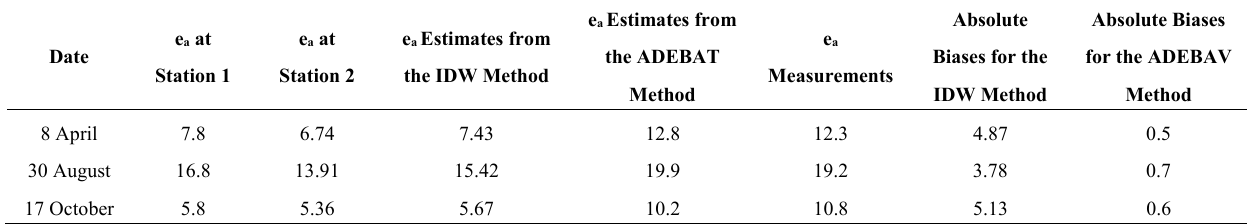
Table 3. Comparisons between the estimated vapor pressure by the IDW method and the ADEBAT method and the e a measurements at Dongping Lake (hpa). ADEBAV, advection-energy balance for air water vapor